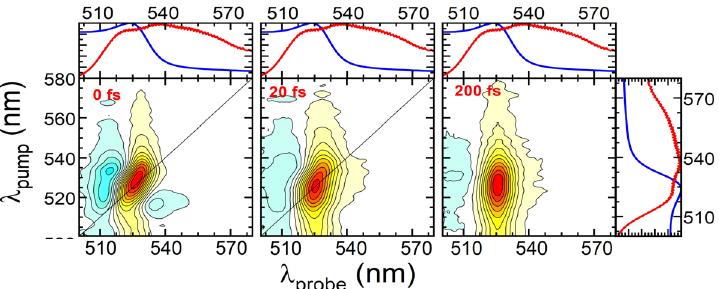
Fig. 3. 2DES maps for CH 3 NH 3 PbBr 3 thin films at an excitation density of 5x10 17 cm −3 at 0, 20 and 200 fs. The dynamics of the width of the bleach signal along and across the diagonal suggest fast dephasing times and low inhomogeneous broadening. The exciton bleach signal is strongly broadened along the pump axis, also at pump wavelengths below the excitonic